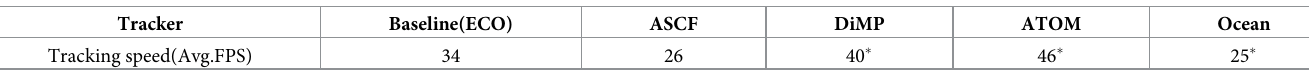
Table 7. The amount of frames processed per second (fps) with different trackers.